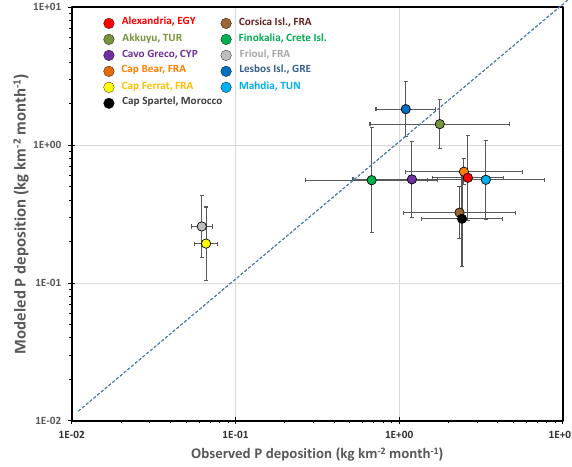
Figure 4. Comparison of modeled and observed monthly geomet- ric mean of total P (Pdust + Pcomb) deposition fluxes at the nine ADIOS stations (Guieu et al., 2010) and soluble PO 4 at Frioul and Cap Ferrat stations (de Fommervault et al., 2015). Each point is the geometric mean of monthly observed and modeled values at the given station over 1 year, namely 2005 for the model and June 2001–May 2002 for the ADIOS observations (only 6 values are available at Alexandria to compute the observed mean and SD, 10 at Mahdia, and 11 at Finokalia) and between 2007 and 2012 for the observations at Frioul and Cap Ferrat stations. Error bars repre- sent the geometric SD on model ( y axis) and measurements ( x